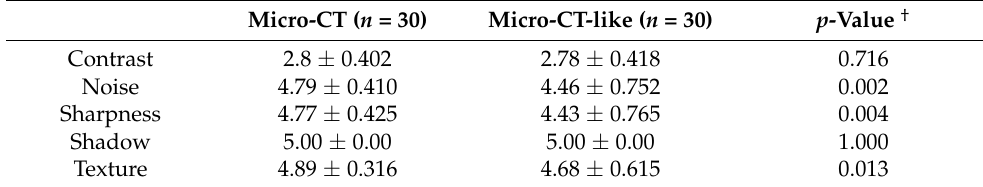
Table 3. Comparison of the subjective mean scores of micro-CT and pix2pixHD-derived micro- CT-like